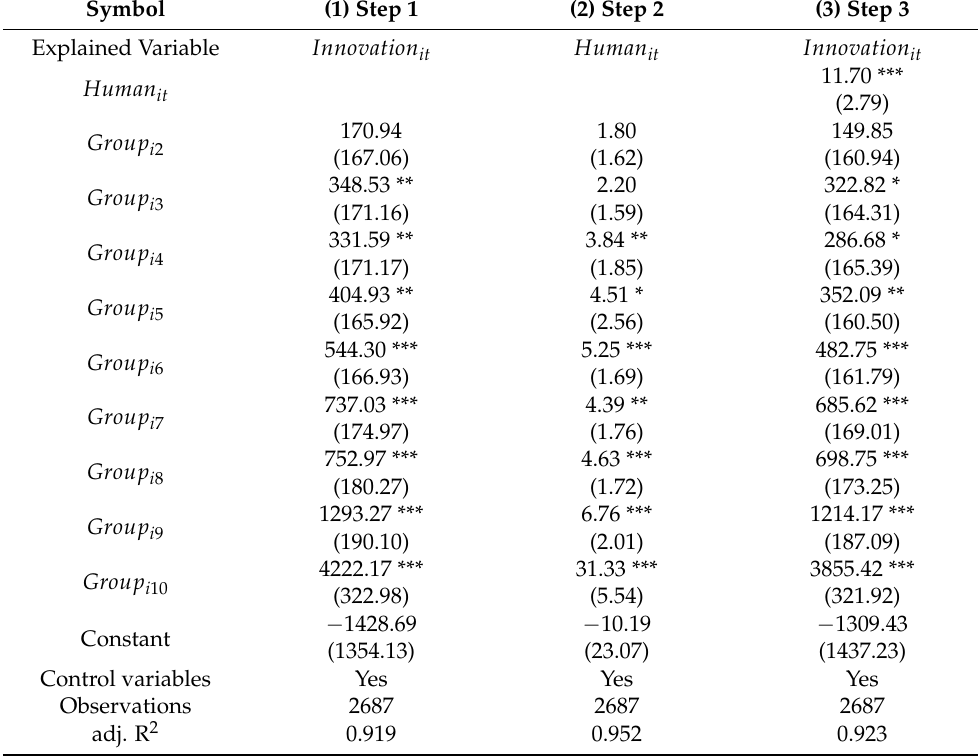
Table 3. Result comparison of the three steps of Model